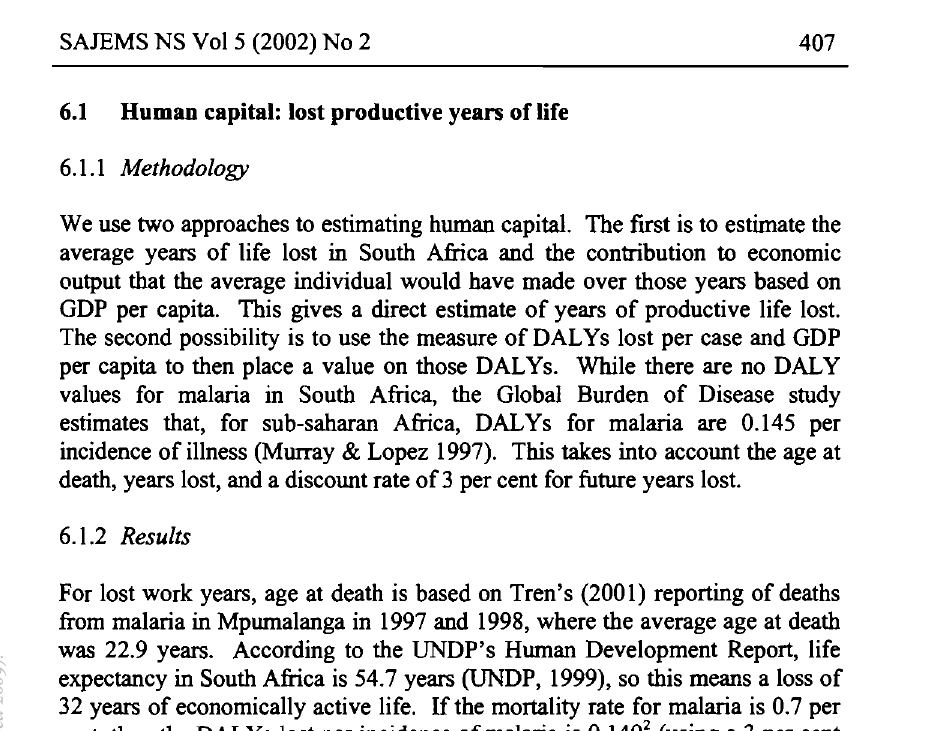
DALYs lost and economic valuation for malaria mortality using GDP per capita,